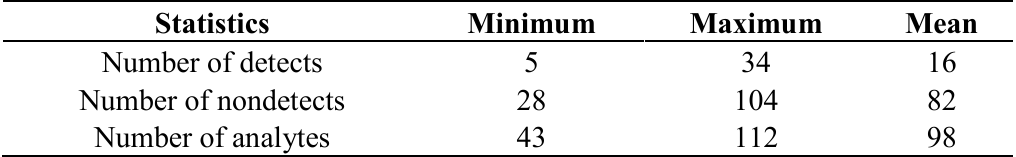
Table 2. The number of analytes and detects in the final set of 618